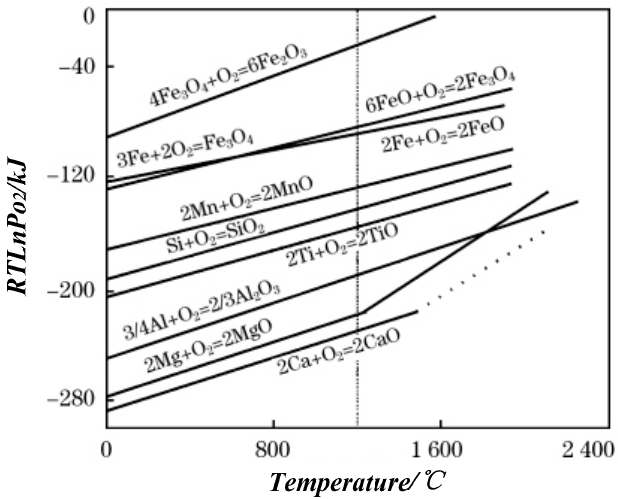
∆ G 0 –T relationship of metal oxidation Figure 5. Δ G 0 –T relationship of metal oxidation reaction. Figure 5.